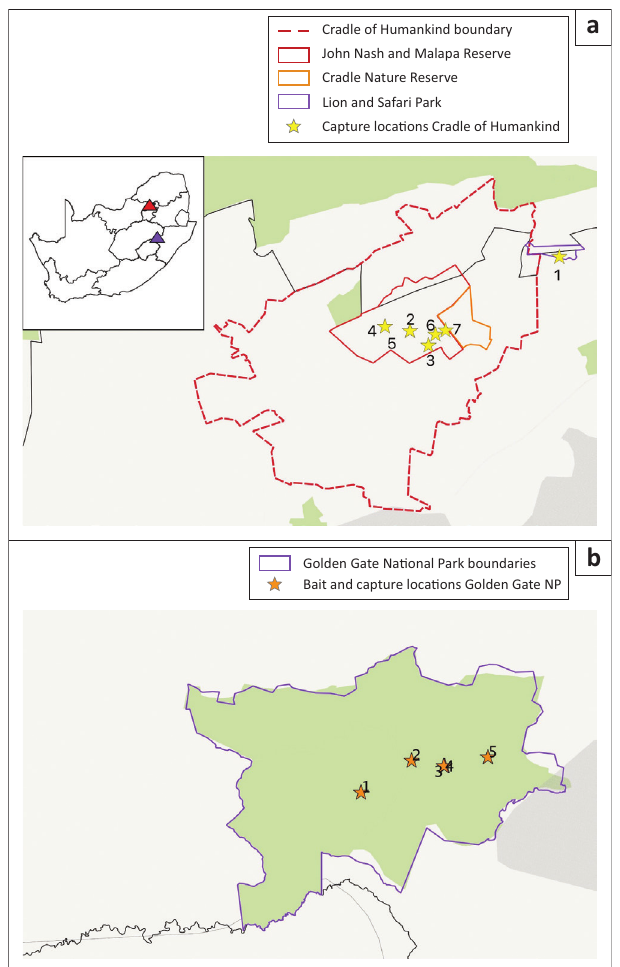
FIGURE 1: Map showing: (a) the seven capture sites at the John Nash and Malapa Reserve, Cradle Nature Reserve and the Lion and Safari Park in Gauteng and North West province (red triangle) and (b) the five baiting and capture sites at the Golden Gate National Park, Free State province (purple triangle), South Africa. Provincial and National Parks are shown in light green (the map was constructed using QGIS 3.4 using country boundaries and protected area boundaries downloaded and used with permission from protectedplanet.net and